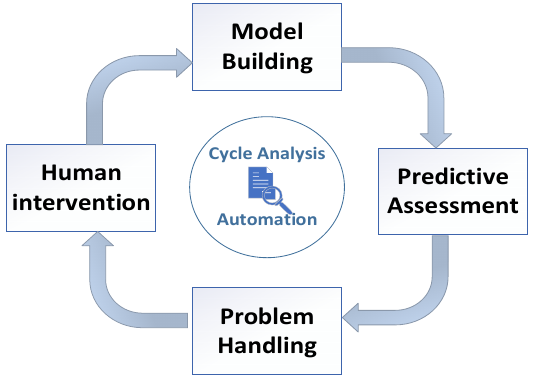
Figure 3. Flowchart of prophet model.